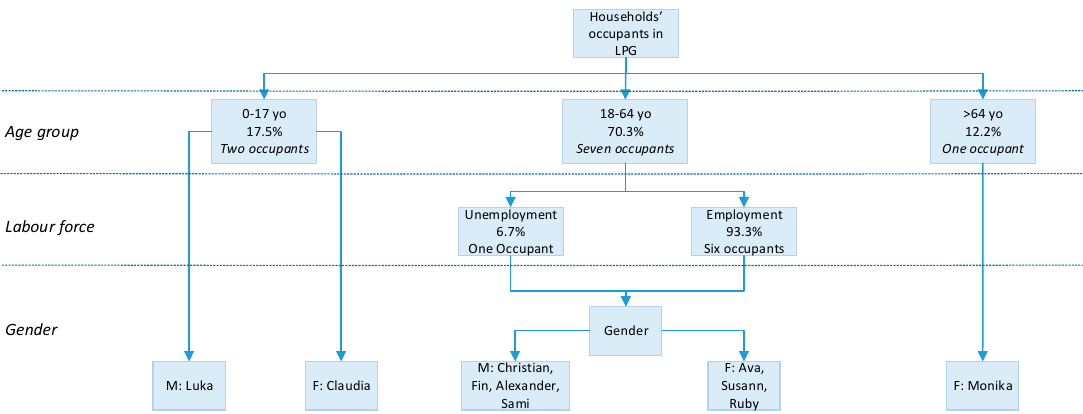
Figure 6. The application of the Wepro model’s structure for Amsterdam’s household occupancy profiles in LPG. It consists of the Amsterdam’s age group share, labour force composition share and gender share of each age group, their capacity of the occupants to be modelled and the selected gender character provided in LPG.